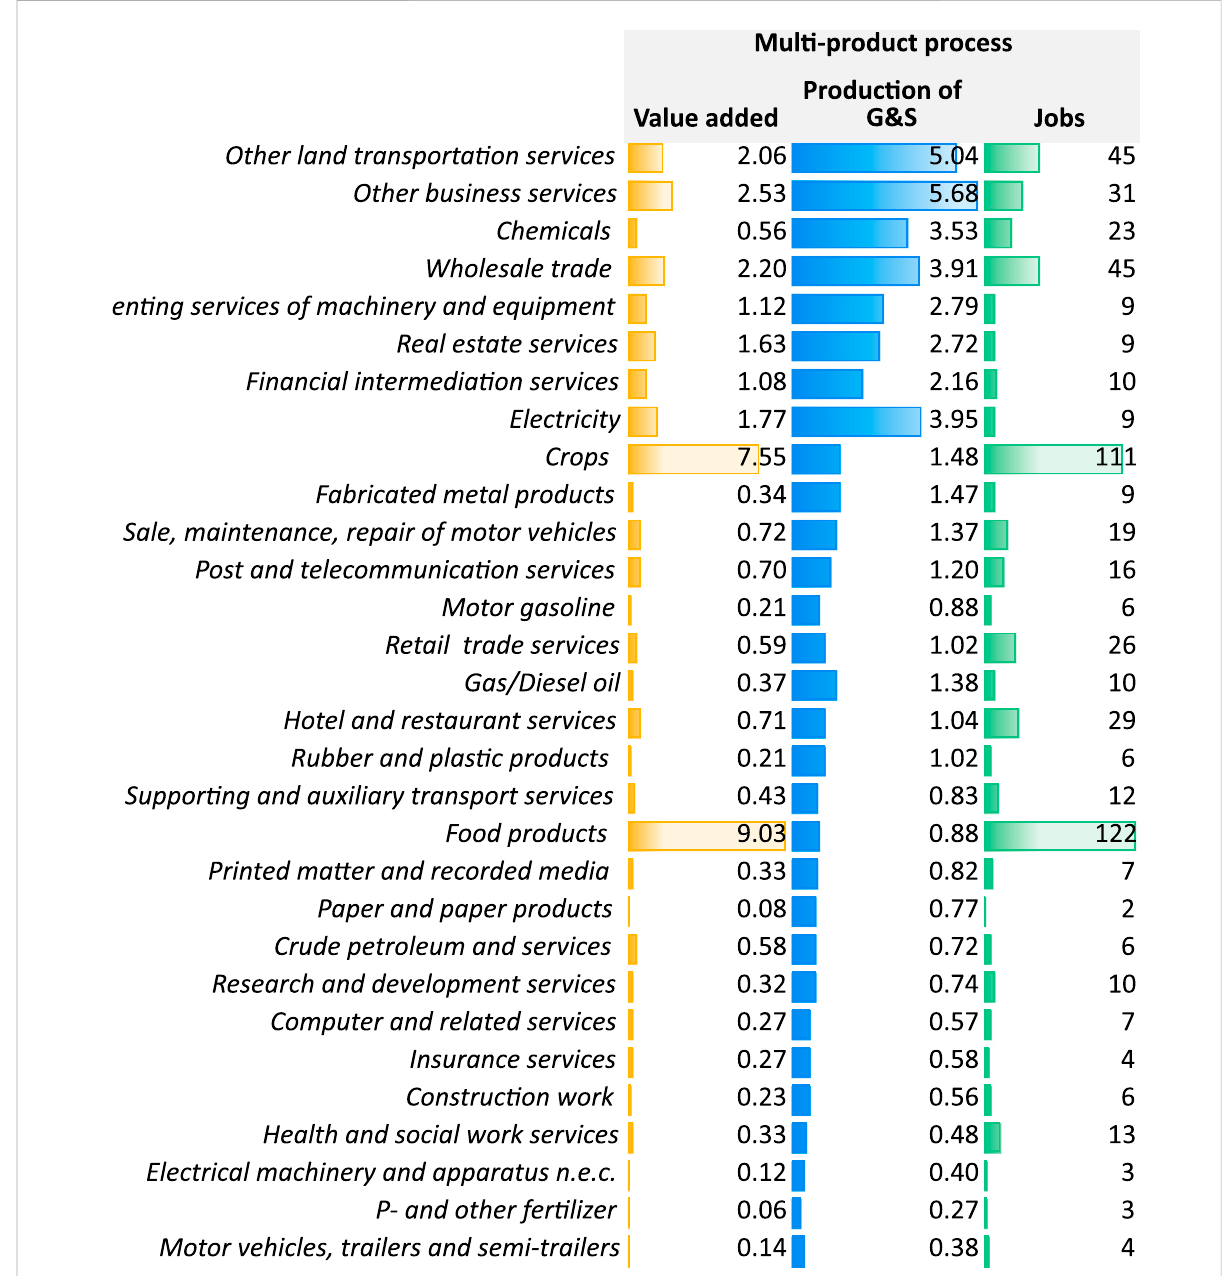
FIGURE 5 Impacts of value added, production of goods and services (G&S) and jobs on economic sectors (Top-30 ranked sectors are